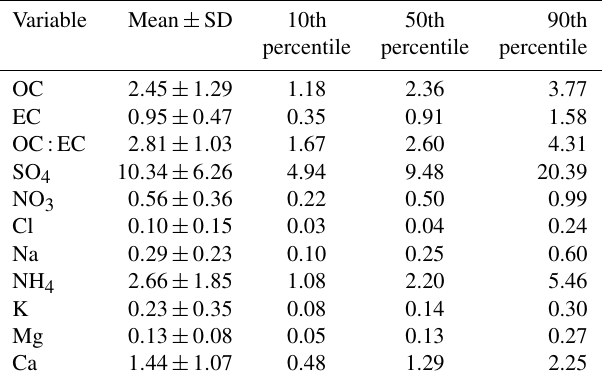
Table 3. PM 2 . 5 concentrations and statistics for EC, OC, and their ratio and water-soluble ions, measured in 52 4d samples. Units for components are µgm − 3